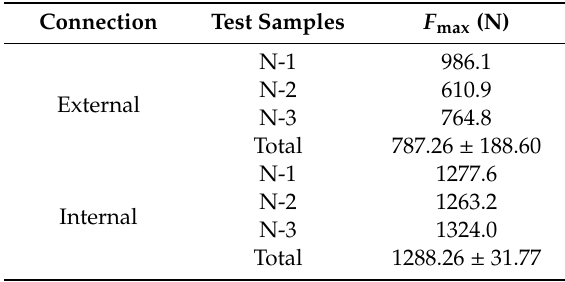
Table 2. Representation of the maximum load results determined in the static test (F = Force).